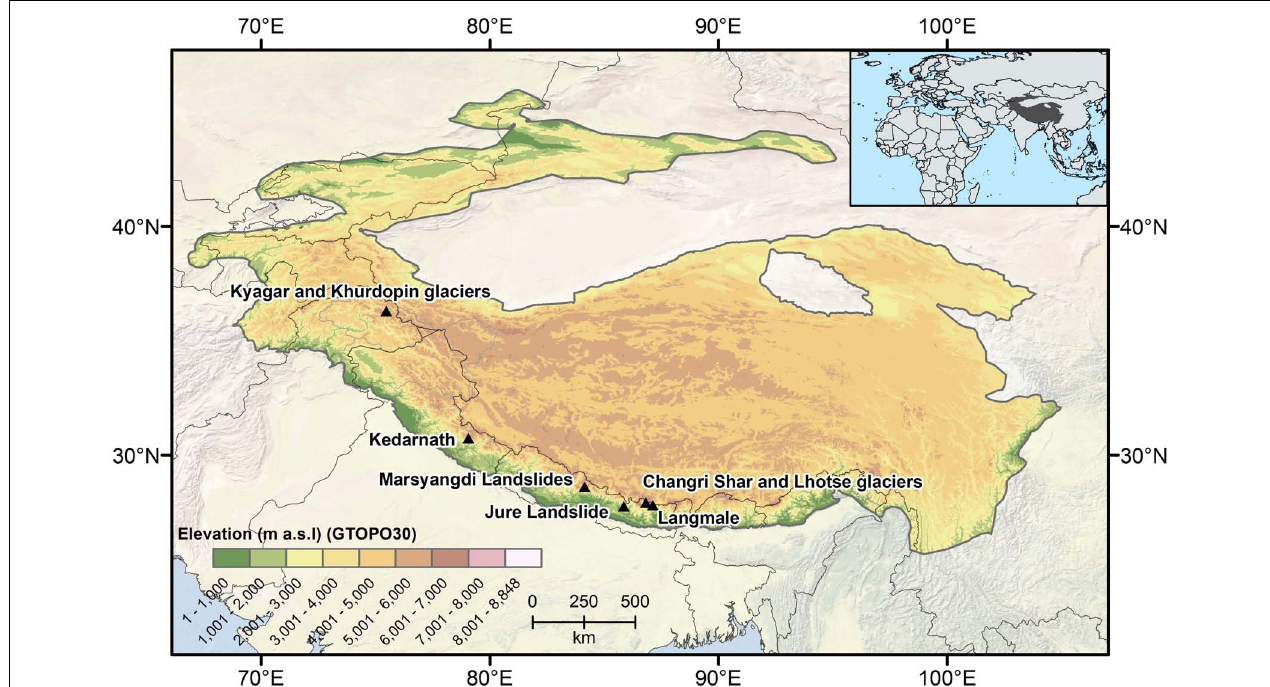
FIGURE 1 | Extent of the HMA Study area (Bolch et al., 2019). The location of case studies from Section “Case Studies of Cascading Hazards Over HMA” are highlighted in the black triangles.